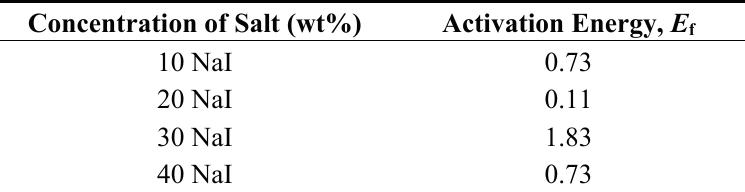
Table 1. Activation energy for the relaxation frequency in the bulk, E f , with various concentrations of